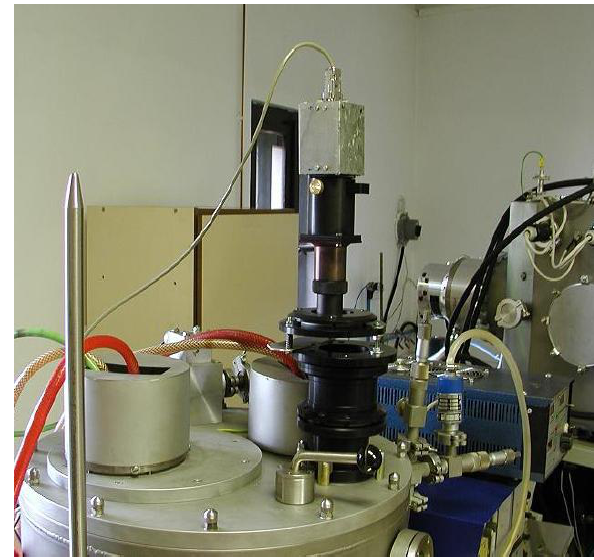
Fig. 4. Photosensor of transmitted light on the sputtering